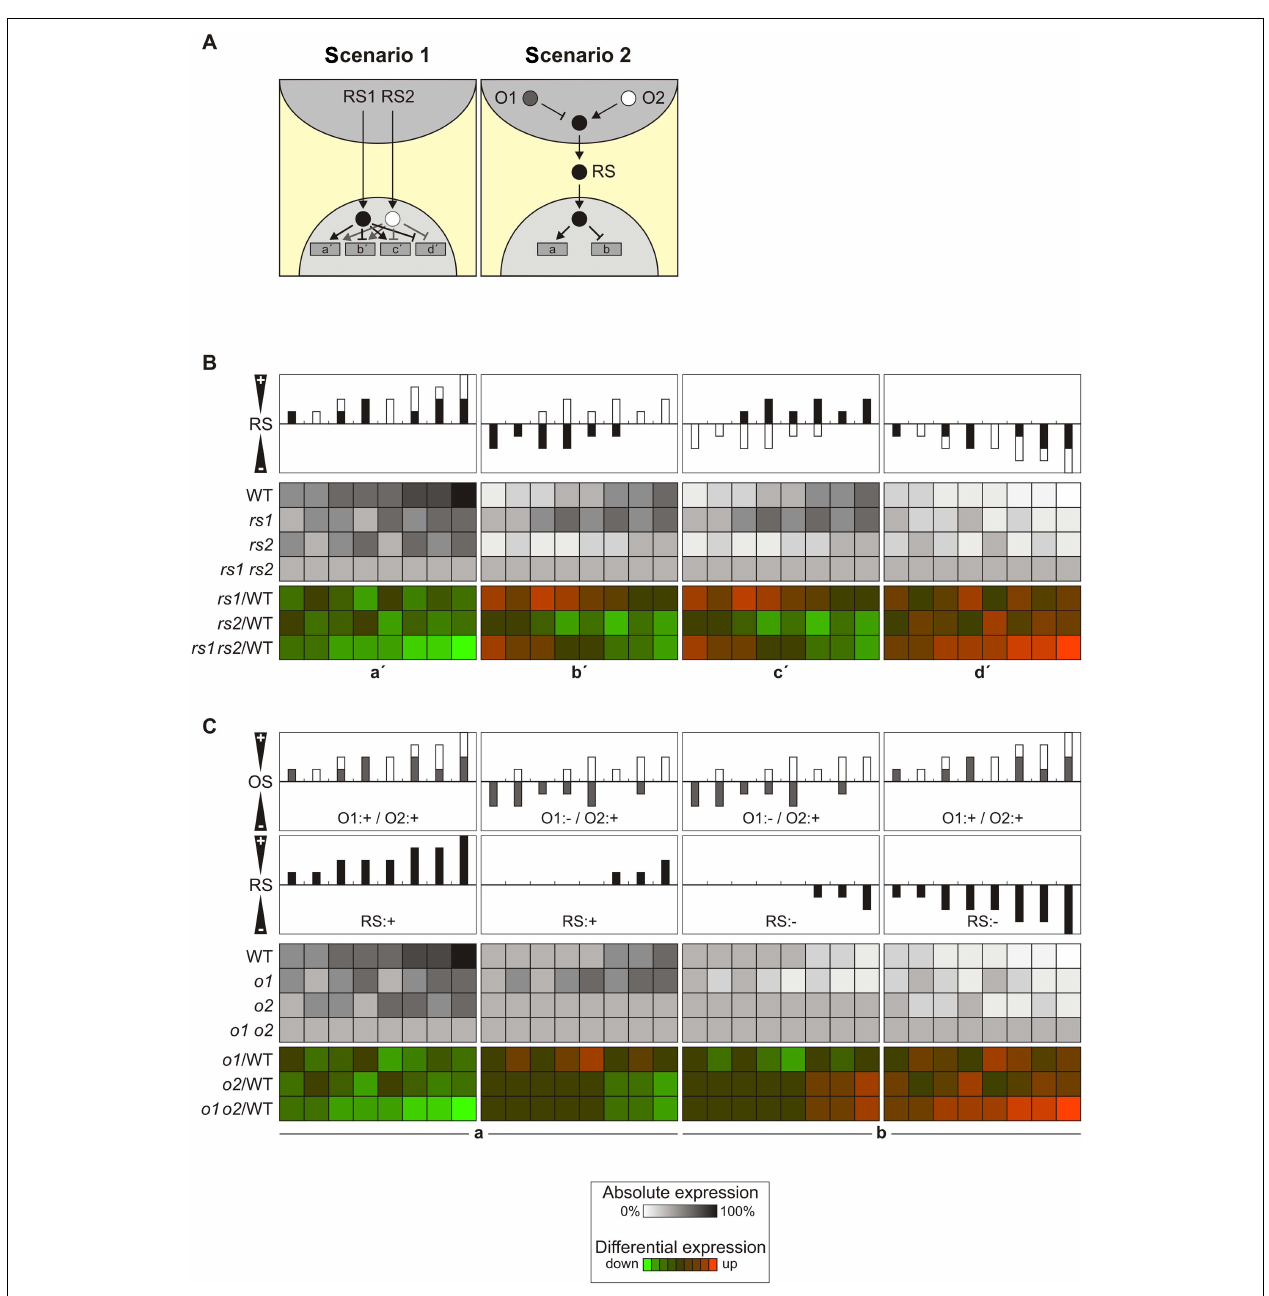
shown inWT and corresponding single ( rs1 and rs2 ) and double ( rs1 rs2 ) signaling mutants in grayscale. In color scale, effects on differential gene expression (mutant versusWT) are shown. In the left/right panel, the expected impact of additive inducing/repressing effects of the retrograde signals on genes a (cid:2) and d (cid:2) is shown. In the middle panel (b (cid:2) /c (cid:2) ), the two retrograde signals act antagonistically and the outcome for the expression of genes b (cid:2) and c (cid:2) is very similar. (C) As in (B) , the two organellar signals can act additively with the same polarity (O1: + /O2: + ) or act antagonistically (O1: − /O2: + ; O1: + /O2: − ; upper panel).The net effect of OS1 and OS2 on RS is shown in the second uppermost panel and can either induce gene expression (the two left panels, gene a) or repress gene expression (the two right panels, gene b).The resulting effects on NGE are again shown in grayscale for absolute expression and in color scale for differential expression (mutant